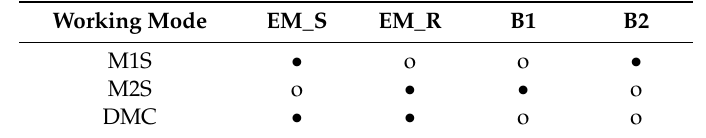
Table 1. System operation